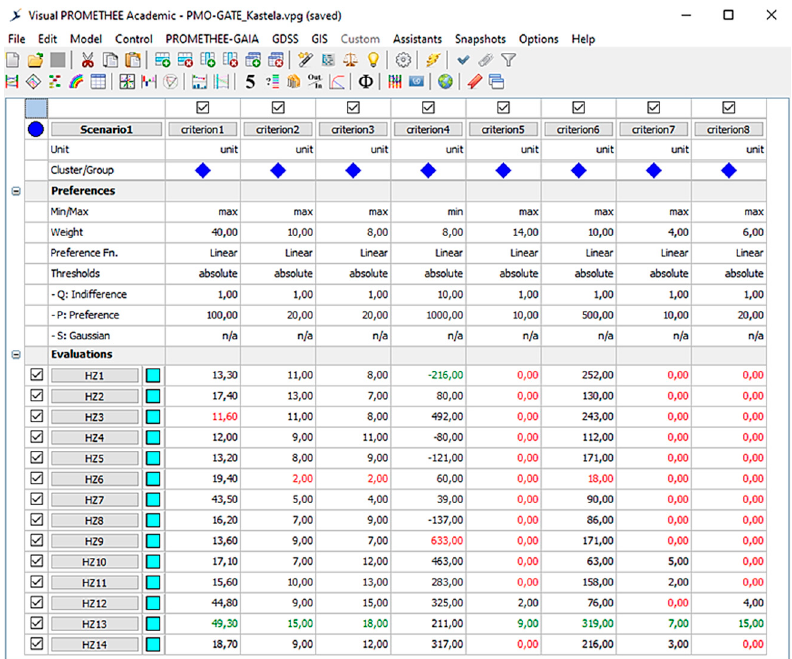
Figure 11. Homogenous zones input data for PROMETHEE method (decision matrix).